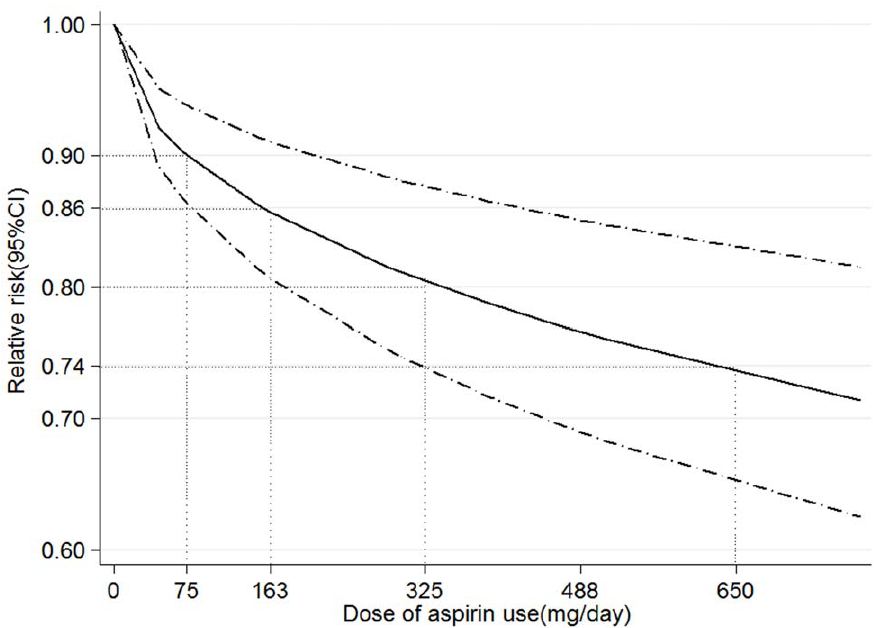
Figure 3. Association between dose of aspirin use and risk of colorectal cancer obtained by spline regression with 3 knots (0, 163, 488 mg per day) and 0 mg per day as reference. P non-linearity =0.020. Solid line represents the estimated relative risk and the dot-dashed lines represent the 95% confidence intervals. The dotted lines are used to explain the relative risk of colorectal cancer for different dose of aspirin use (RR=0.90, 95% CI 0.86–0.94, for 75 mg per day; RR=0.86, 95% CI 0.81–0.91, for 163 mg per day; RR=0.80, 95% CI 0.74–0.88, for 325 mg per day; RR=0.74, 95% CI 0.65–0.83, for 650 mg per day).